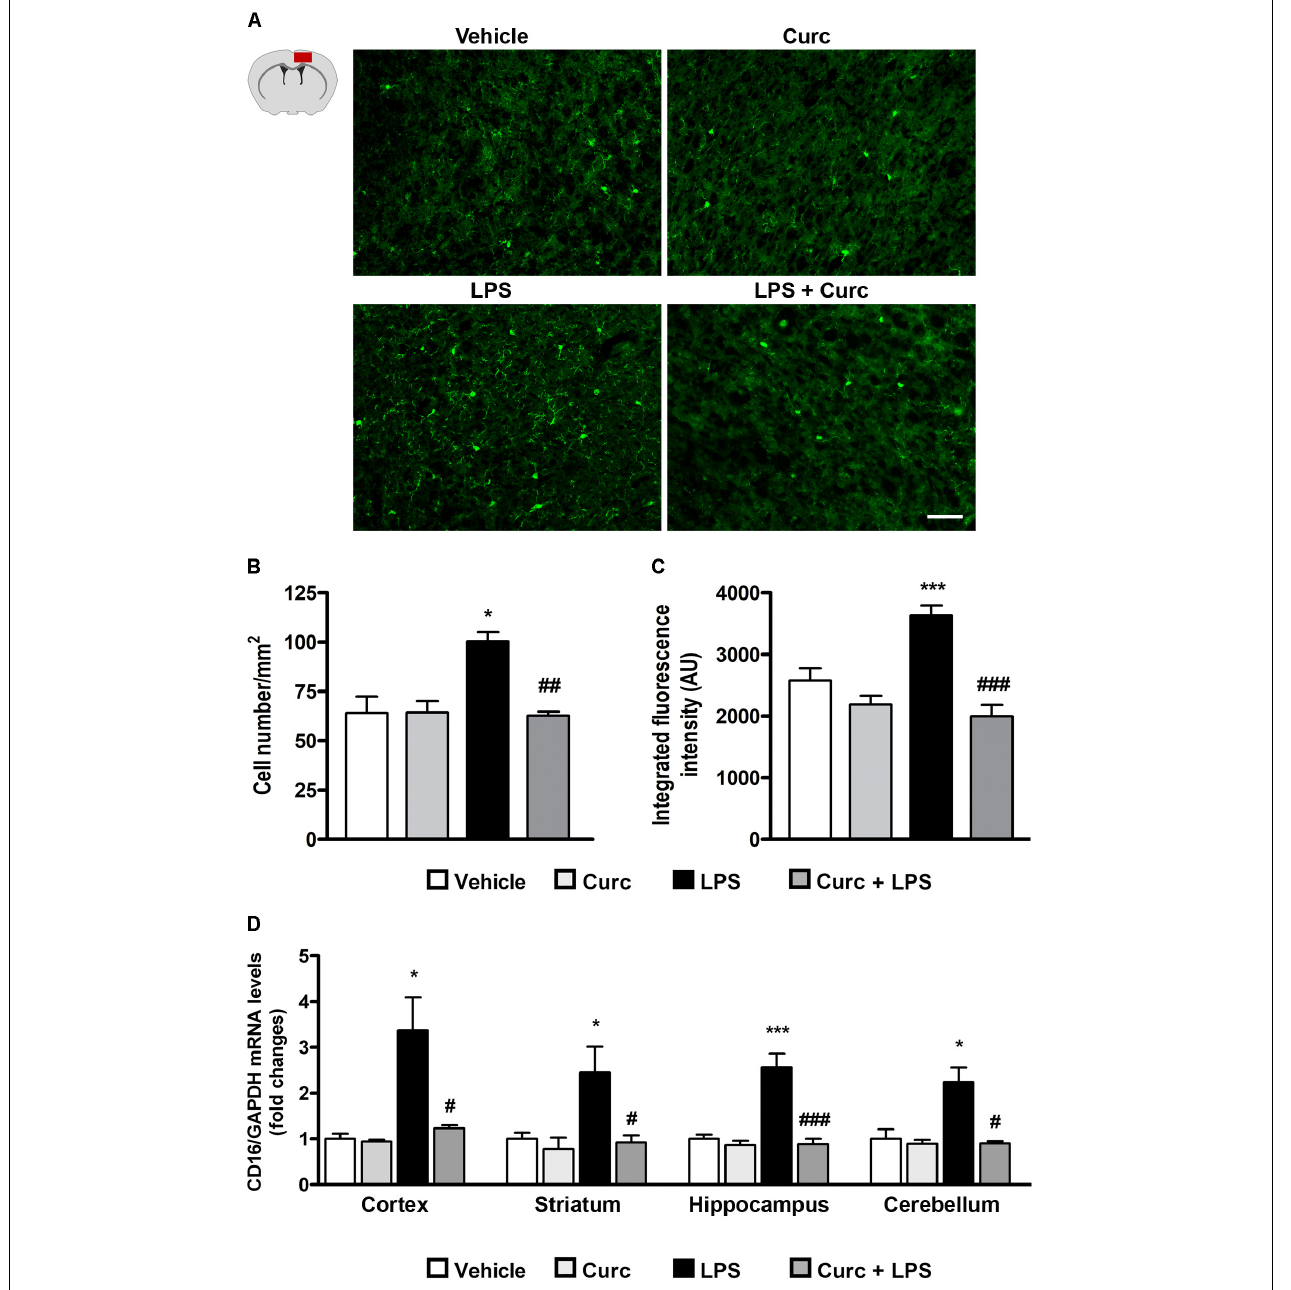
FIGURE 3 | Curcumin inhibits acute microglial cell activation in response to peripheral LPS administration. Mice treated for 2 consecutive days with curcumin (curc; 50 mg/kg) received a single i.p. injection of LPS (5 mg/kg). Two hours following LPS or saline injection, mice were sacrificed and the whole brain, cerebral cortex, striatum, hippocampus, and cerebellum were extracted and prepared as described in Section “Materials and Methods.” (A) Schematic of the cerebral cortex in the coronal plane indicating the location (red square) of the area examined and representative images of Iba1-stained microglia through the cortex from the four experimental groups. Scale bar, 50 µ m. (B) Bar graphs representing the quantification of the number of Iba1+ microglia in the cerebral cortex. Data are means ± SEM ( n = 5 mice/group). Data were analyzed by one-way ANOVA [ F ( 3 , 16 ) = 17.81, p < 0.0001] followed by Bonferroni’s multiple comparison test. ∗ p < 0.05 vs. control group; ## p < 0.01 vs. LPS-stimulated group. (C) Bar graphs representing the quantification of the mean fluorescence intensity of microglia (Iba1+) in the cerebral cortex. Data are means ± SEM ( n = 5 mice/group). Data were analyzed by one-way ANOVA [ F ( 3 , 16 ) = 5.52, p < 0.0001] followed by Bonferroni’s multiple comparison test. ∗∗∗ p < 0.001 vs. control group; ### p < 0.001 vs. LPS-stimulated group. (D) Mice treated as described above were sacrificed 24 h following LPS or saline injection. Brain areas were extracted and prepared as described in Section “Materials and Methods” and analysis of CD16 mRNA expression levels was conducted via real-time PCR. Data are means ± SEM ( n = 4 mice/group). Data were analyzed by one-way ANOVA [ F ( 15 , 64 ) = 11.18, p < 0.0001] followed by Bonferroni’s multiple comparison test. ∗∗∗ p < 0.001 vs. control group; # p < 0.001 vs. LPS-stimulated group ∗ p < 0.05 and ∗∗∗ p < 0.001 vs. control group; # p < 0.05 and ### p < 0.001 vs. LPS-stimulated group.